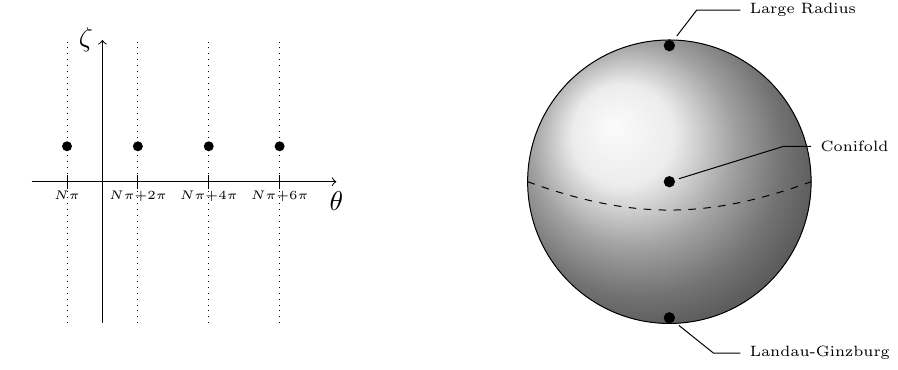
Figure 1 . K(cid:127)ahler moduli space: FI-theta space (left) and compacti(cid:12)ed version